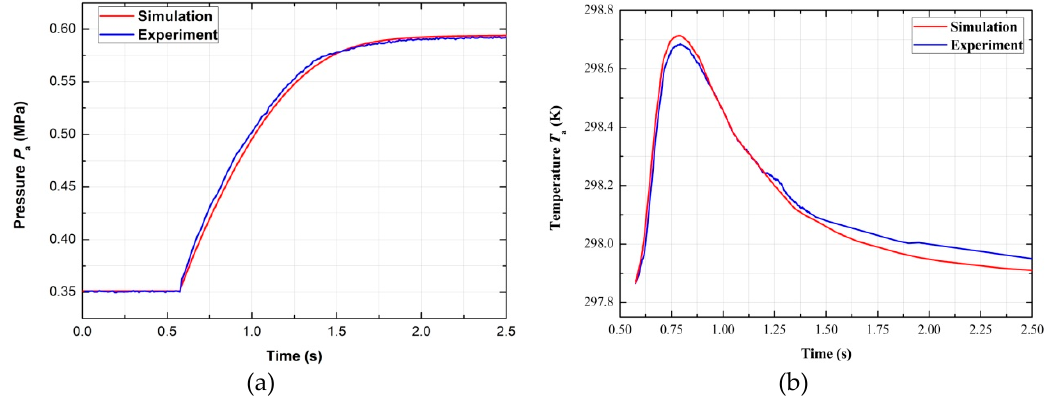
Figure 22. Curves of pressure and temperature when chamber a is charging: ( a ) Pressure curves; ( b ) Temperature curves.